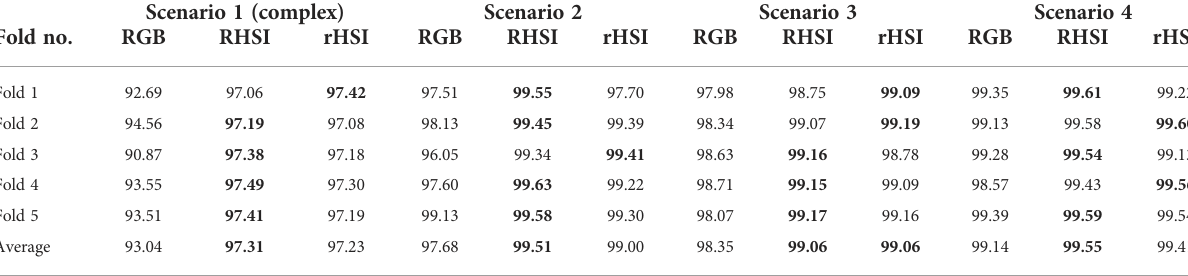
TABLE 3 Detection OA (%) of individual folds in the 5-fold cross validation process. Scenario 1 (complex) Scenario 2 Scenario 3 Scenario 4 Fold